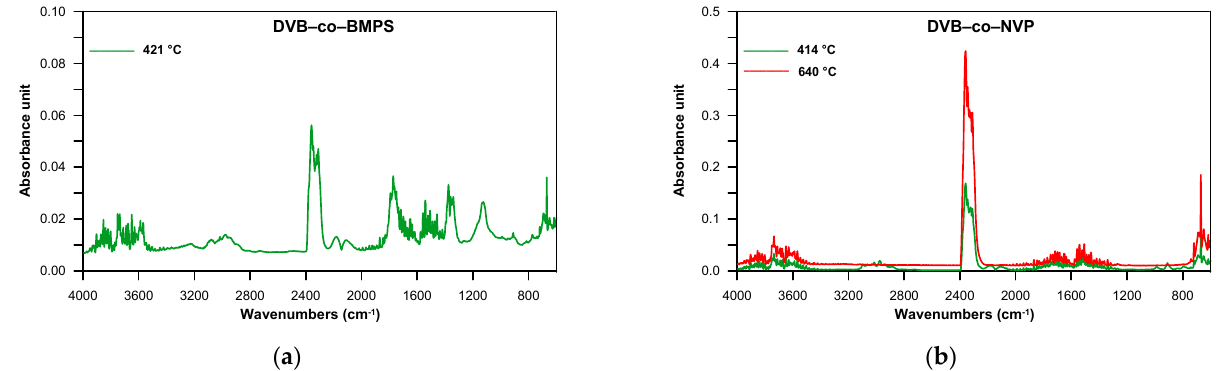
Figure 7. FTIR spectra of volatile products evolved during the thermal decomposition of DVB- co -BMPS and DVB- co -NVP copolymers collected at the maxima of decomposition in helium atmosphere. ( a ) DVB- co -BMPS; ( b ) DVB- co -NVP.